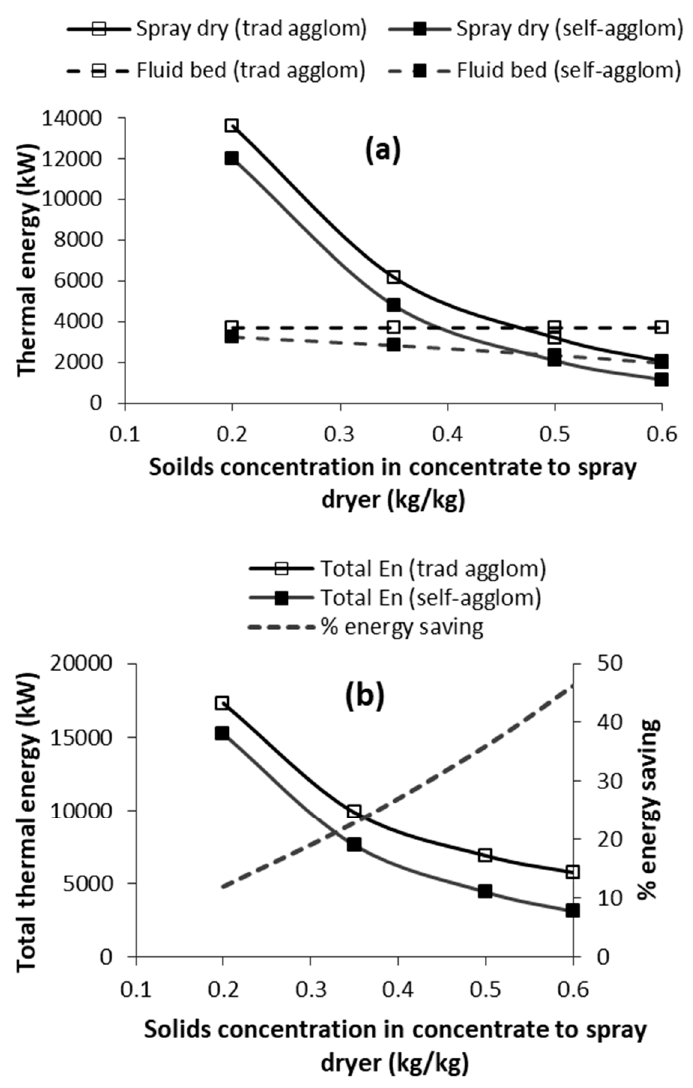
Figure 6. Effect of solids concentration ( X c ) in the concentrate to the spray dryer on thermal energy requirements of traditional agglomeration and self-agglomeration: ( a ) spray drying and fluid-bed energy; and ( b ) total energy and % saving in energy due to self-agglomeration as compared to traditional agglomeration. [ R wp = 0.5; X b = X c for self-agglomeration].